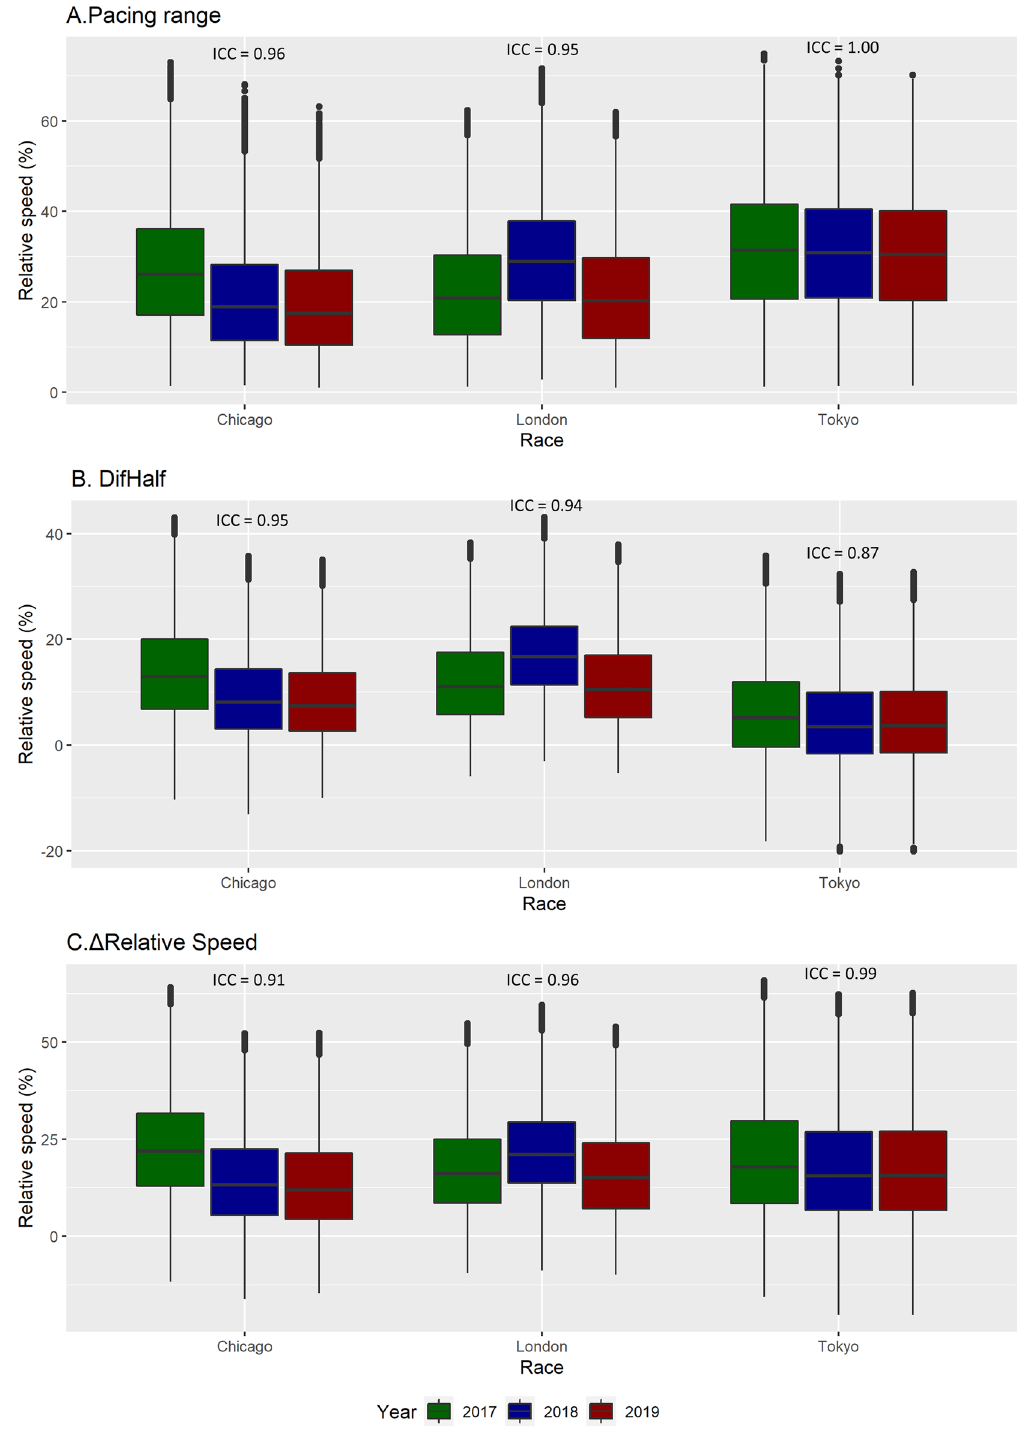
Figure 4. Boxplots of pacing range ( A ), DifHalf ( B ), and ΔRelative speed ( C ) of the marathons assessed. Intraclass correlation coefficients (ICC) between editions are shown for each marathon. No differences ( p > 0.05 and ES < 0.8) were observed between marathon